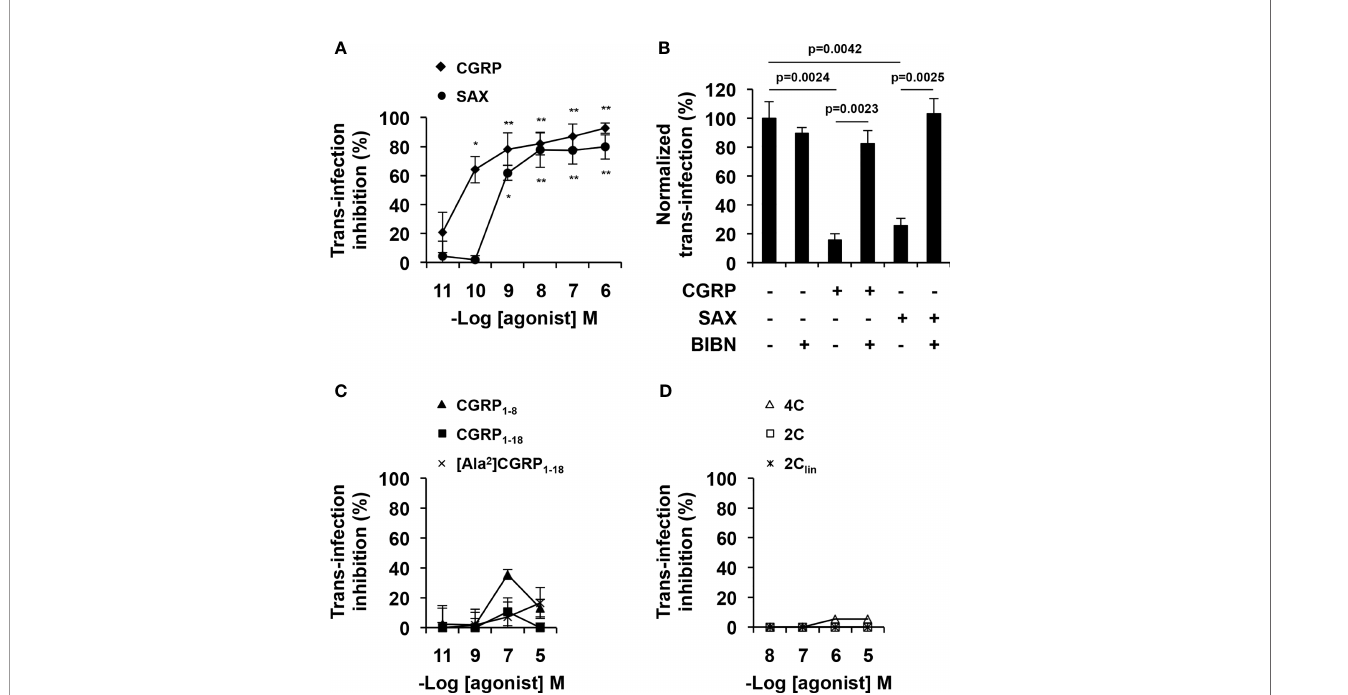
FIGURE 3 | CGRP and SAX, but not CGRP peptide fragments, inhibit MDLCs-mediated HIV-1 trans-infection. MDLCs were left untreated or treated for 24 h with the indicated molar concentrations of CGRP, SAX or CGRP peptide fragments. In panel (B) , the CGRP receptor antagonist BIBN4096 (BIBN, 1 m M) was added 15 min before addition of agonists (0.1 m M). The cells were then pulsed with HIV-1 ADA for 4 h, washed, and incubated for 7 days with autologous CD4+ T-cells (A – C) or 3 days with HIV-1 GFP-reporter T-cells (D) . HIV-1 trans-infection and replication in T-cells was evaluated by p24 ELISA in the co-culture supernatants or by GFP expression and fl ow cytometry. Shown are mean- ± SEM percentages of HIV-1 trans-infection inhibition (A, C, D) or normalized (B) , derived from n = 5 (A) and n = 3 (B – D) independent experiments using MDLCs from different individuals. *p < 0.0500, **p < 0.0050, two-sided Student ’ s